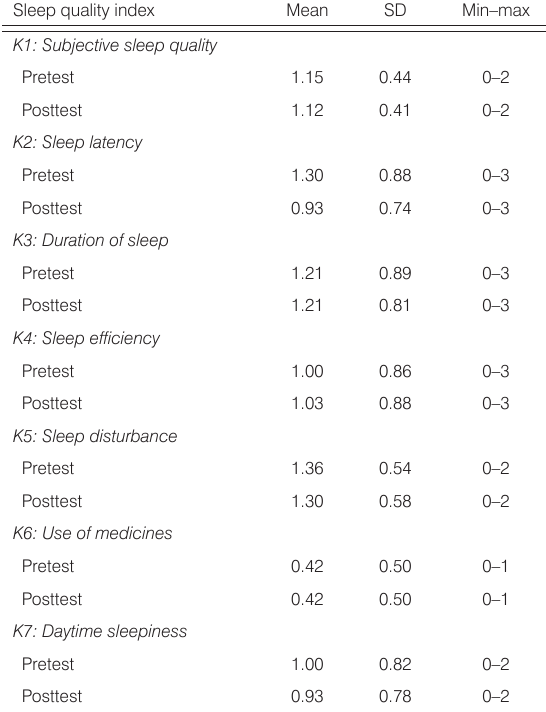
Table 3. Sleep quality in the control group ( n